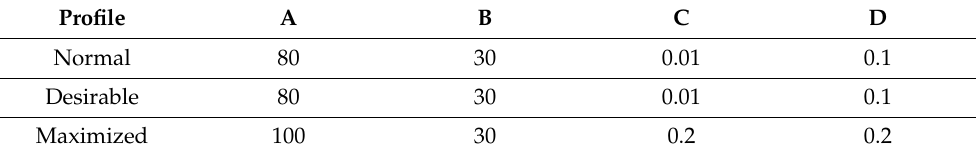
Table 7. Best design values with normal desirable and maximized